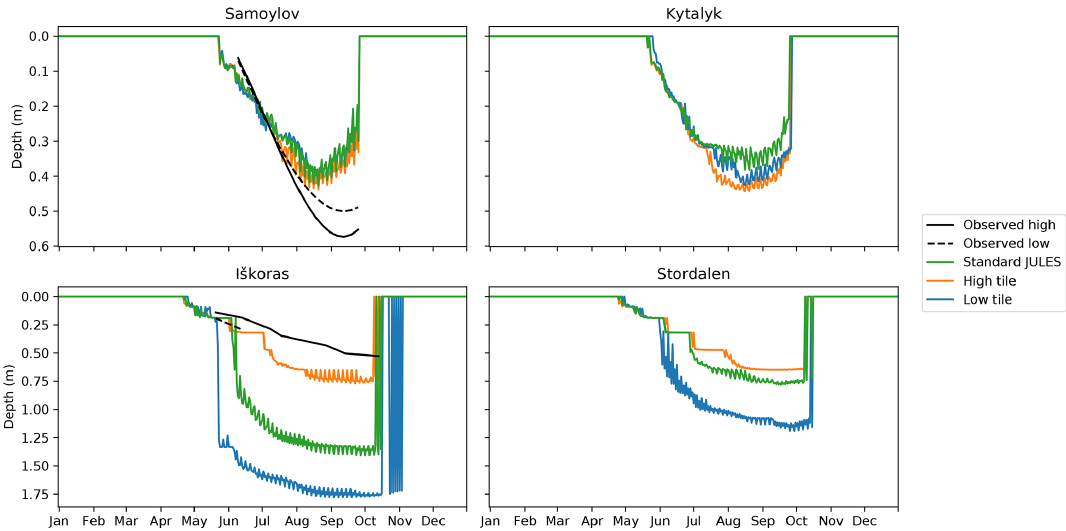
Figure 11. Climatologies (2002–2016) of modelled vs. observed thaw depths. Observed thaw depths for Iškoras were from 2019, Samoylov CALM thaw depths were from 2002–2016, grouped according to classes 1 and 3 and averaged using a third-degree polyfit across